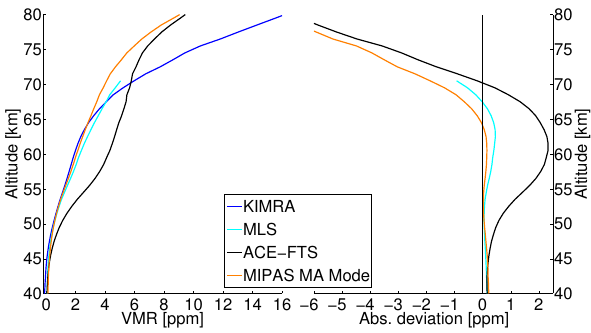
Fig. 17. Comparison of KIMRA with ACE-FTS, MIPAS (MA mode), and MLS using the collocation criteria R =1000km and 1 PV=50%. 1 day with coincidences was found. Left panel: mean profiles derived according to Sect. 5.1. Right panel: deviation be- tween the KIMRA and the satellite profiles calculated with Eq.